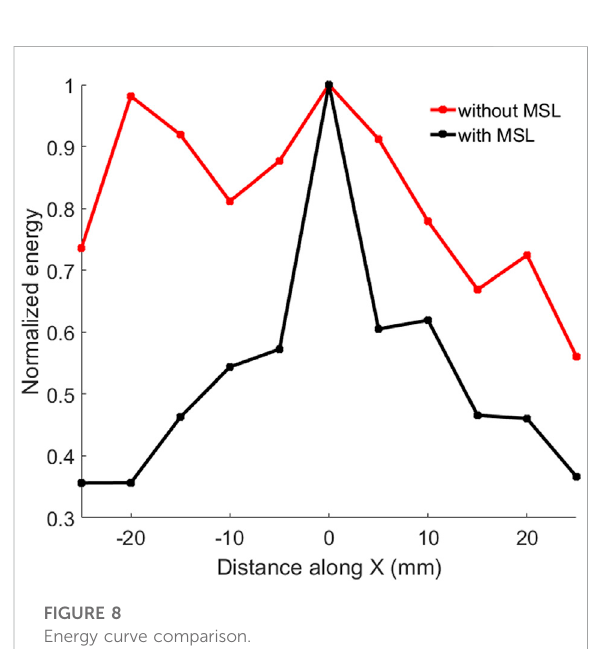
FIGURE 8 Energy curve